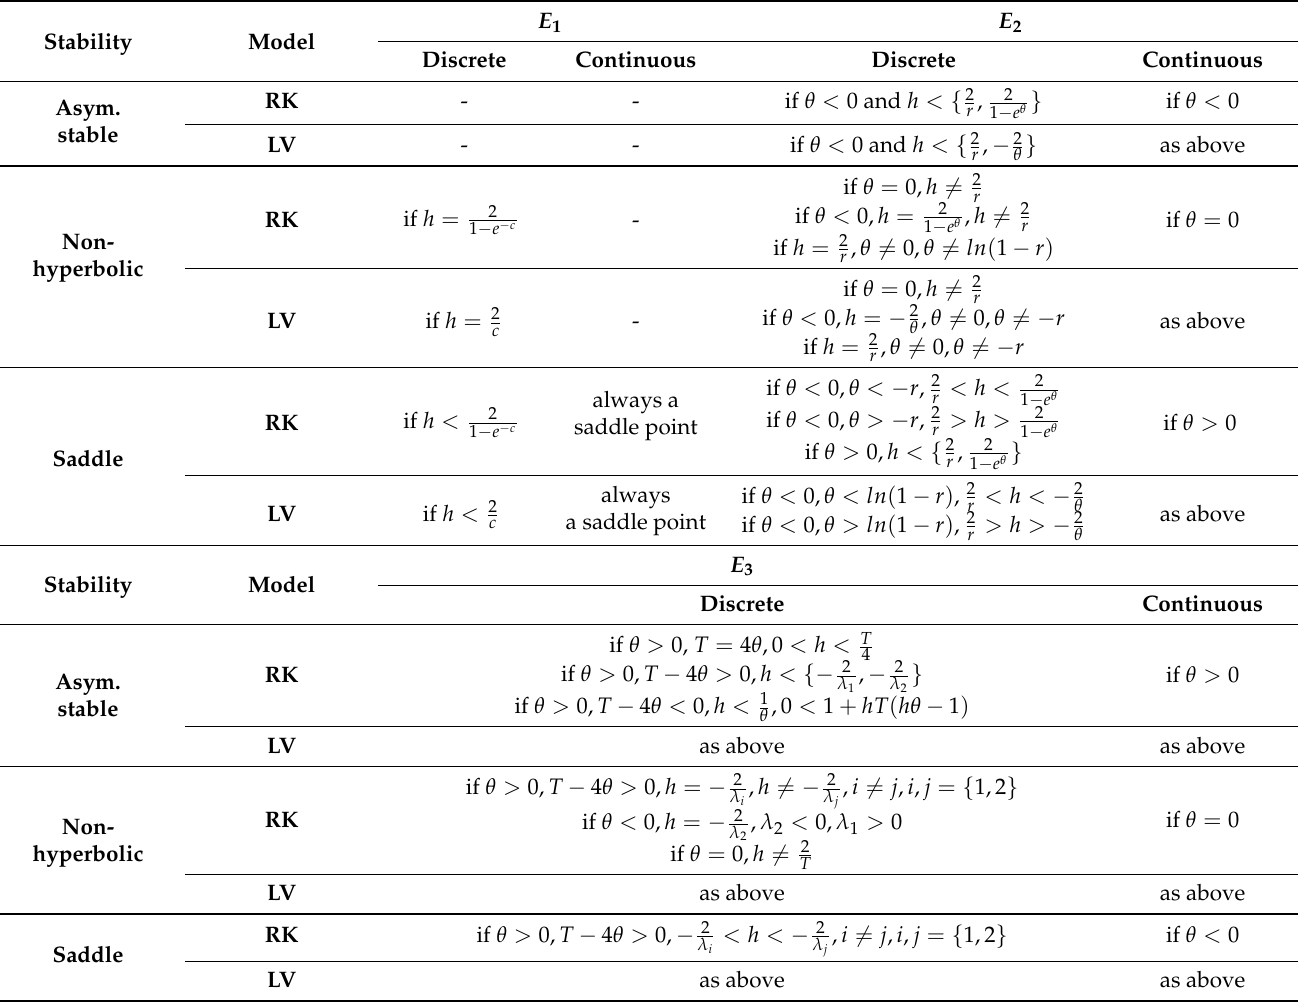
Table 1. Stability status for discrete and continuous Ricker-type (RK) and Lotka-Volterra (LV) models, where E 1 ≡ ( 0,0 ) , E 2 ≡ ( K ,0 ) , E 3 ≡ from